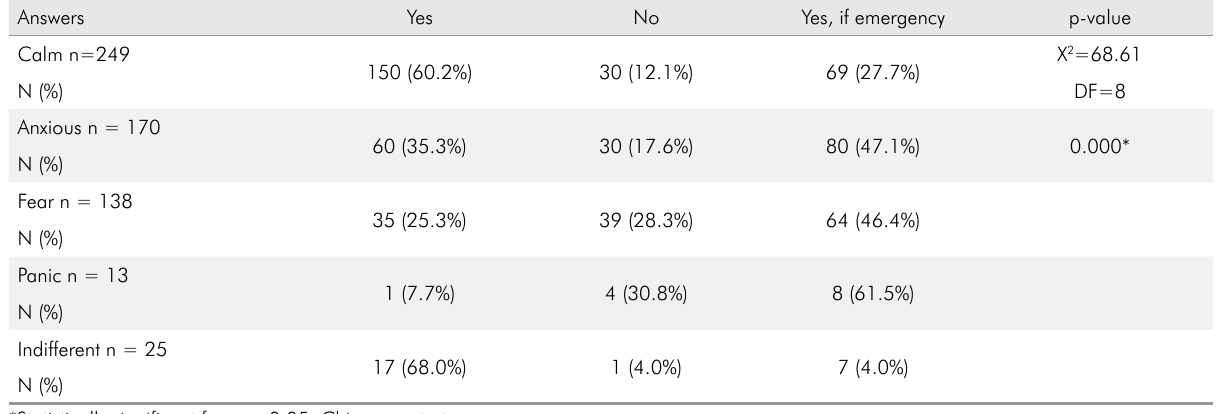
*Statistically significant for p < 0.05; Chi-square